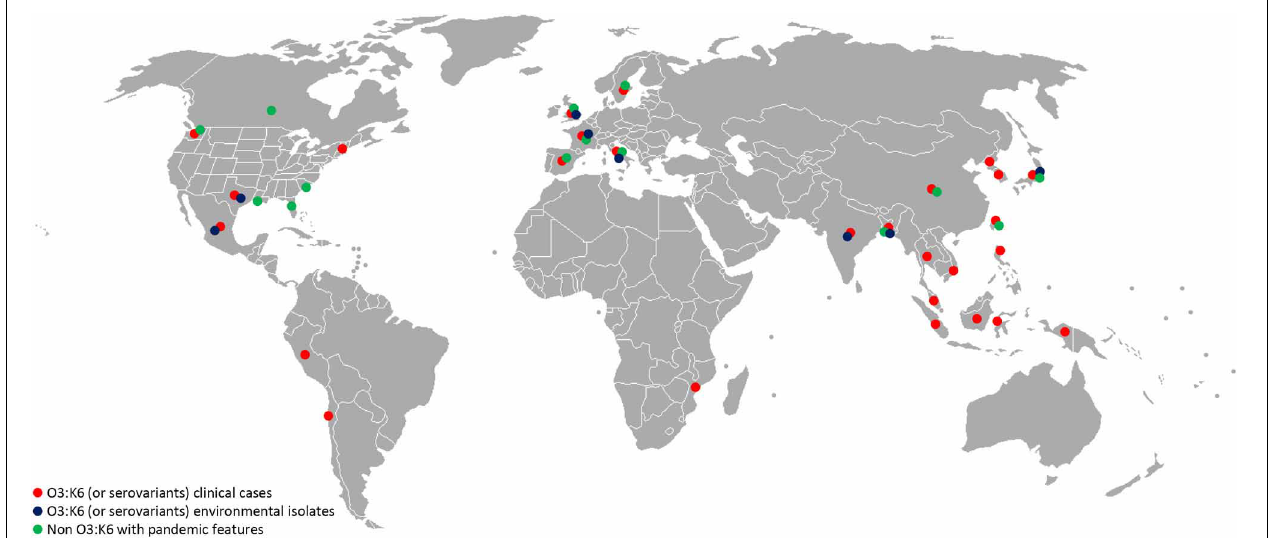
FIGURE 1 | Worldwide distribution of V. parahaemolyticus featuring virulence markers. Red, O3:K6 (or serovariants) clinical isolates; blue, O3:K6 (or serovariants) environmental isolates (water, seafood); green, non O3:K6 strains showing pandemic features ( tdh , trh , PAI, T3SS, and/or T6SS). References to these data are a small portion of the